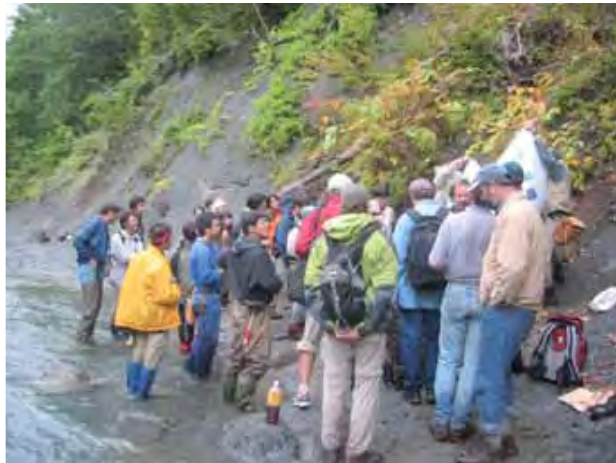
Figure 3. Outcrop of the OAE2 horizon in the Yezo Group,